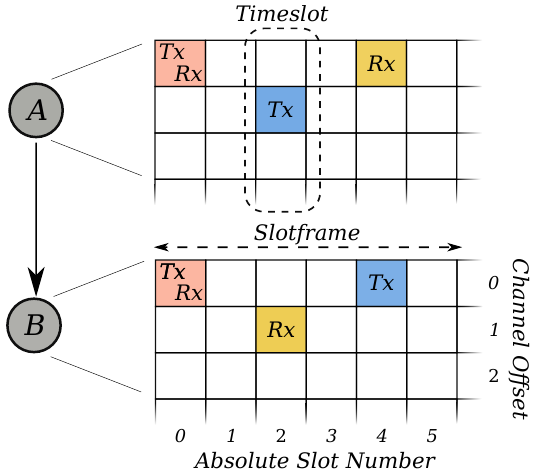
Figure 1. A typical TSCH schedule shared between device A and B, containing a Tx, an Rx, and a TxRx slot for